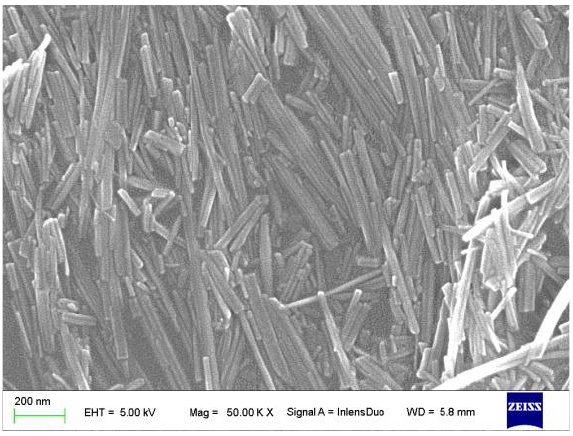
Figure 1. Morphology of